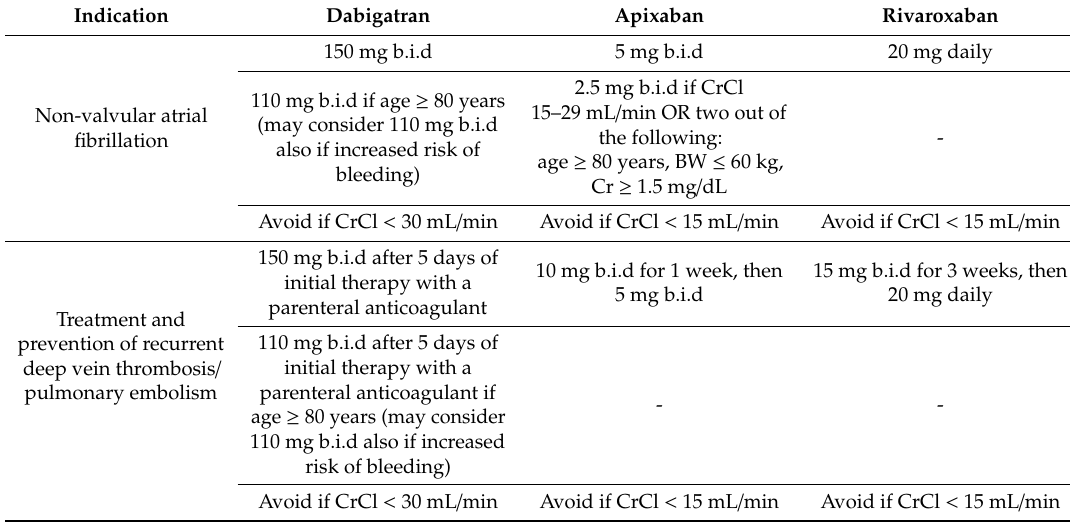
Table 1. Indications and dosing of NOACs in